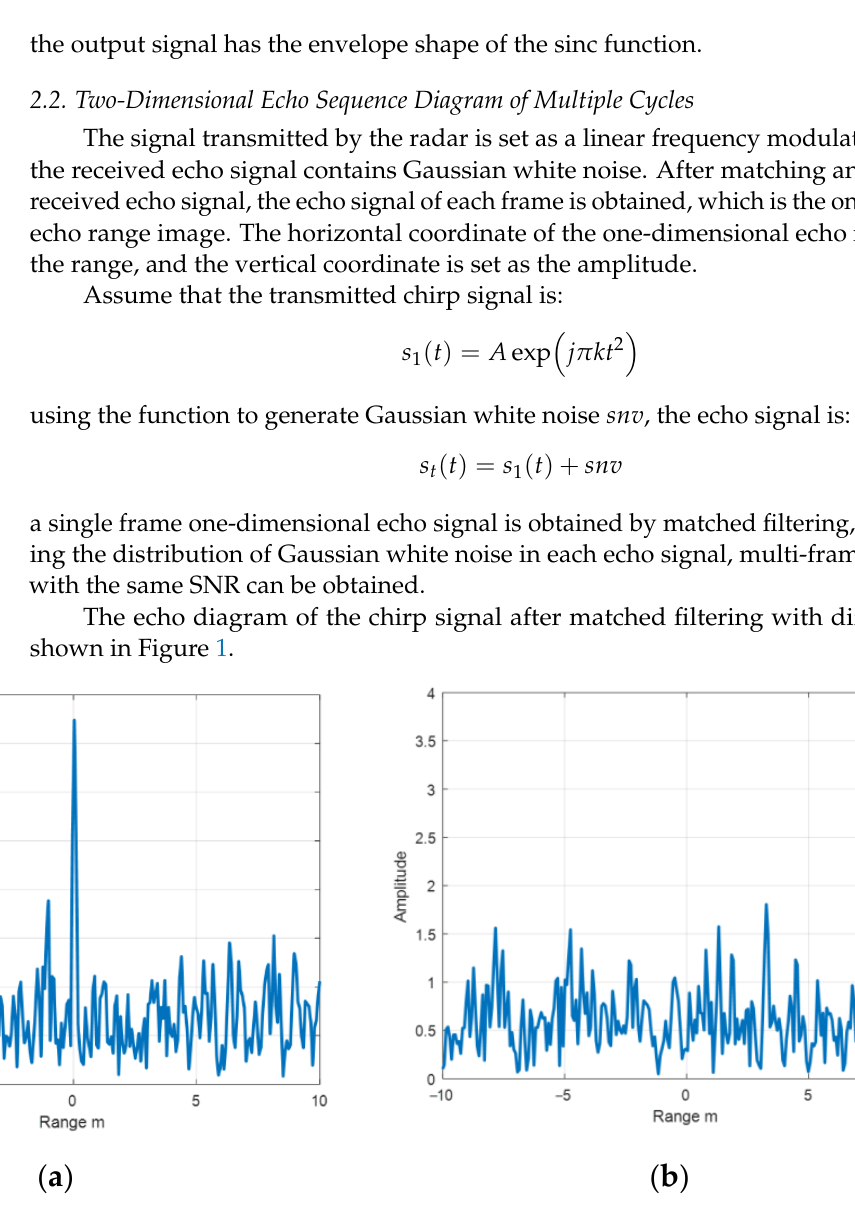
( c ) Figure 2. Two-dimensional echo sequence diagrams of 500 echo cycles under different SNR of ( a ) 12 dB, ( b ) 0 dB, ( c ) − 5 dB. 3. Design of Radar Target Detection Network Radar target detection Network is designed based on Convolution Neural Network. It is a special multi-layer perceptron, which can realize target recognition by extracting various features of original data and then learning according to the features. 3.1. Structure and Parameters of Convolutional Neural Network Convolutional neural network consists of input layer, convolutional layer, pooling layer, fully connected layer, and output layer. In this paper, the convolutional neural network is improved on the classical convolutional neural network Lenet5 [19]. Figure 3 is the structure diagram of the convolutional neural network in this paper.